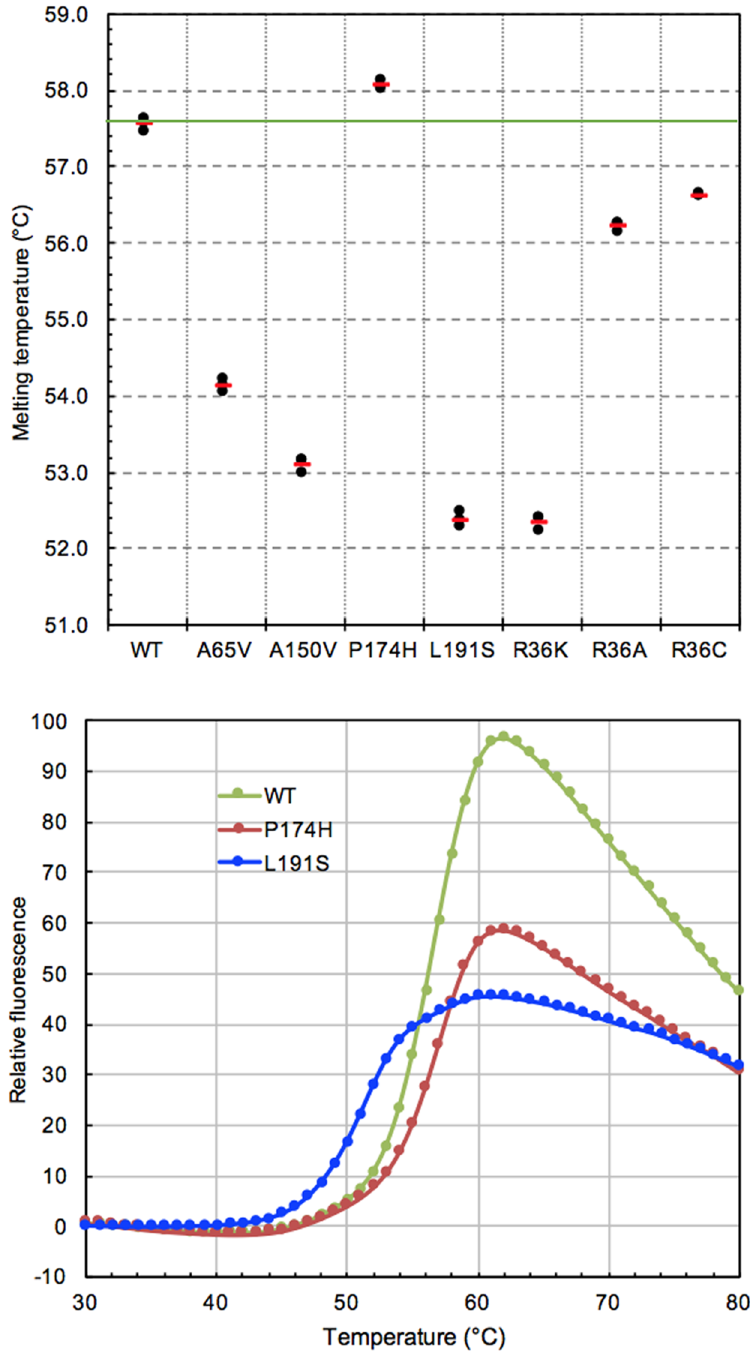
Fig 4. Thermal stability of new variants compared to WT as measured by DSF. Triplicate samples of all variants were subjected to DSF in the same multi-well plate, using conditions described previously [12]. Melting temperatures (black symbols in top panel) were taken as the point where the second derivative of the melting curves (as exemplified in bottom panel) equaled zero. Red bars show average values. Melting temperature for the WT (57.6 ± 0.1 ˚C) seen here is essentially the same as our previous WT measurement (57.7 ± 0.2